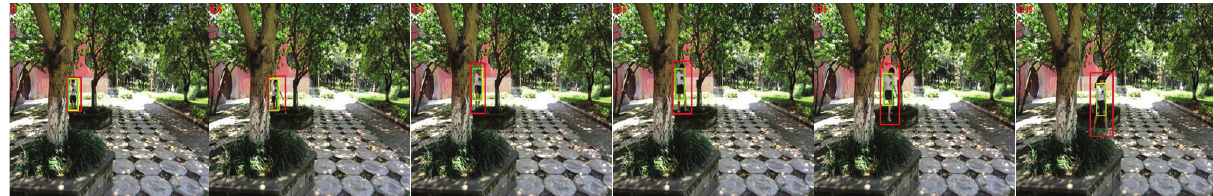
Figure 5: Tracking results of girl pose sequence. Frames 5, 25, 45, 65, 85, and 105 are displayed.